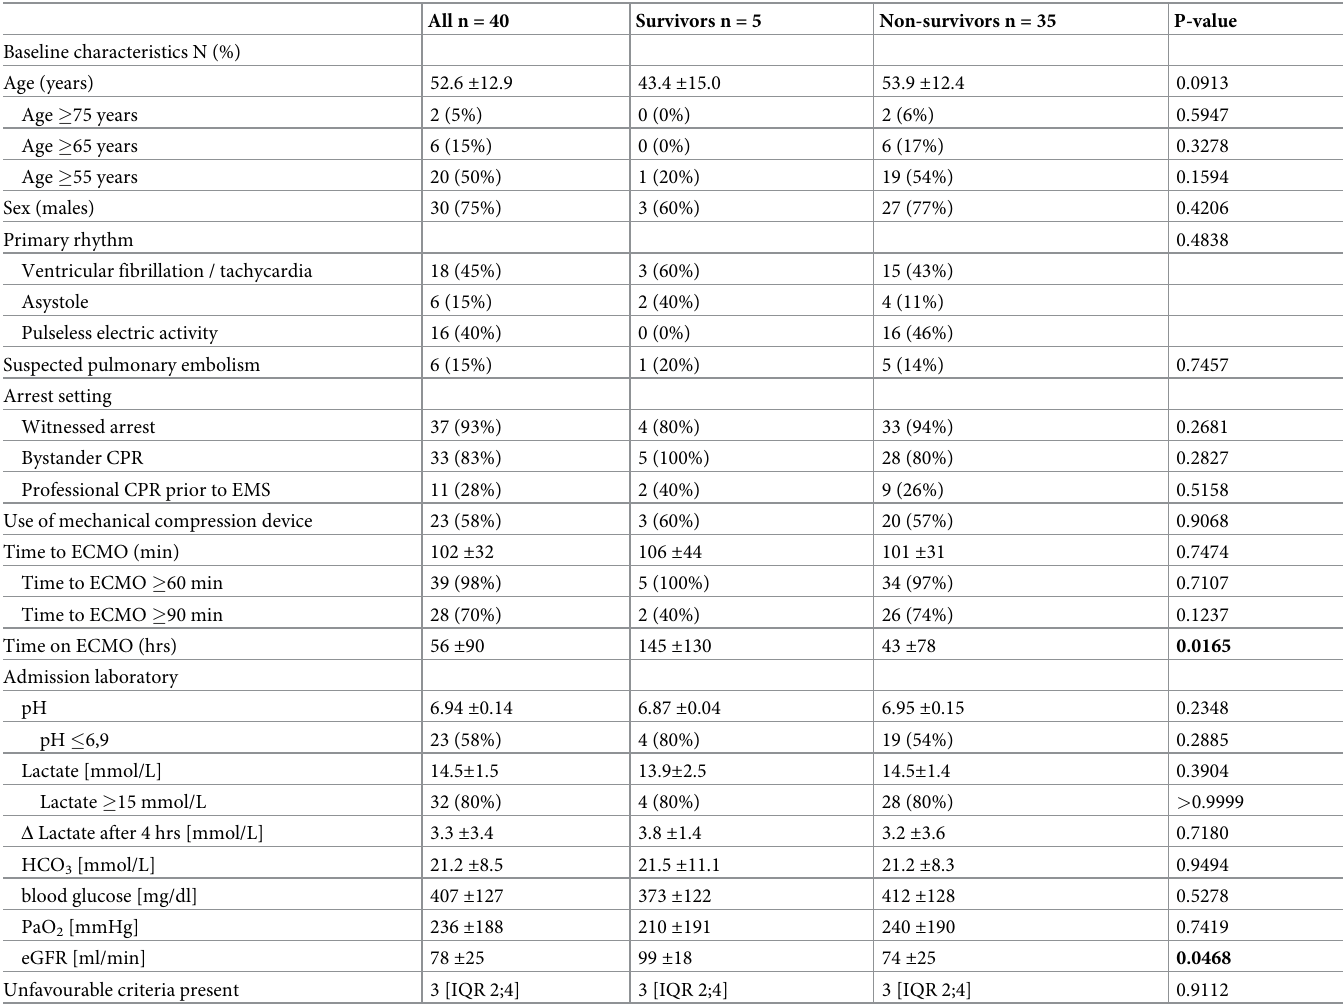
Table 1. Patient